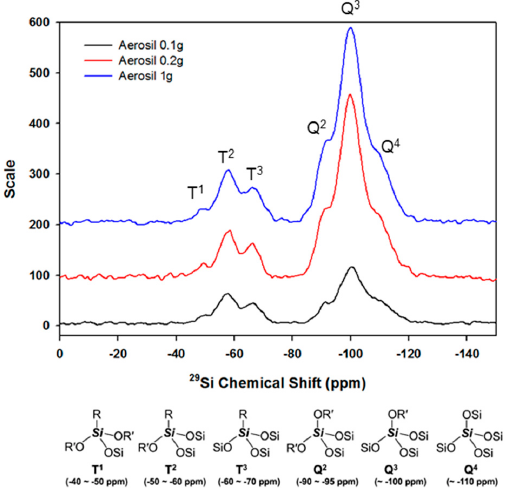
Figure 4. 29 Si CP/MAS NMR spectra for the TCR-1 sample by aerosol contents.